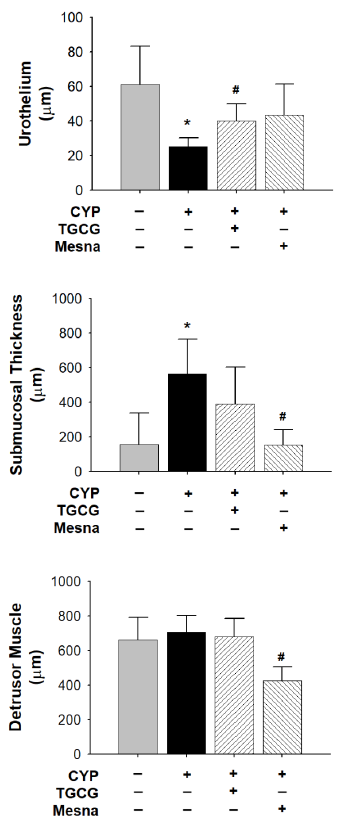
Figure 3. H&E stain for histological examination in bladder cross sections between control, CYP, CYP + TGCG, and CYP + Mesna groups in the female rats.